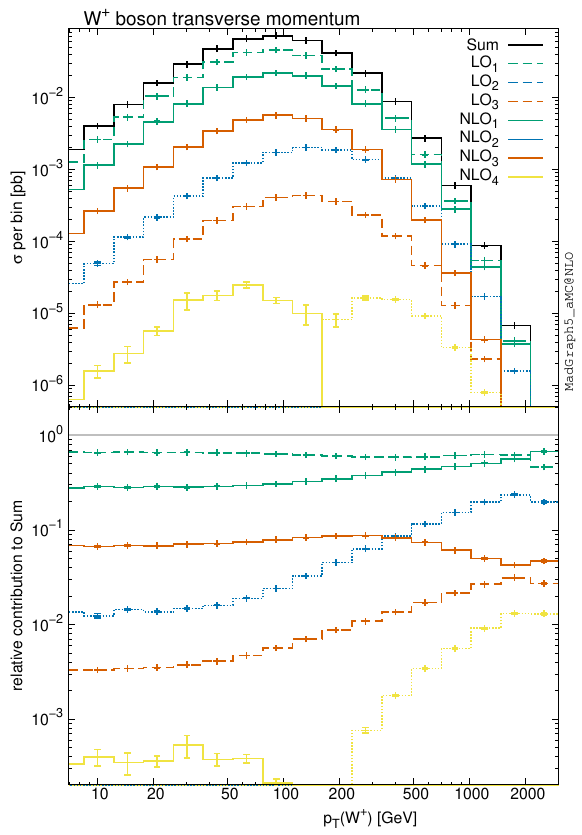
Figure 12. Transverse momentum of the W + boson in pp ! t (cid:22) tW + production.